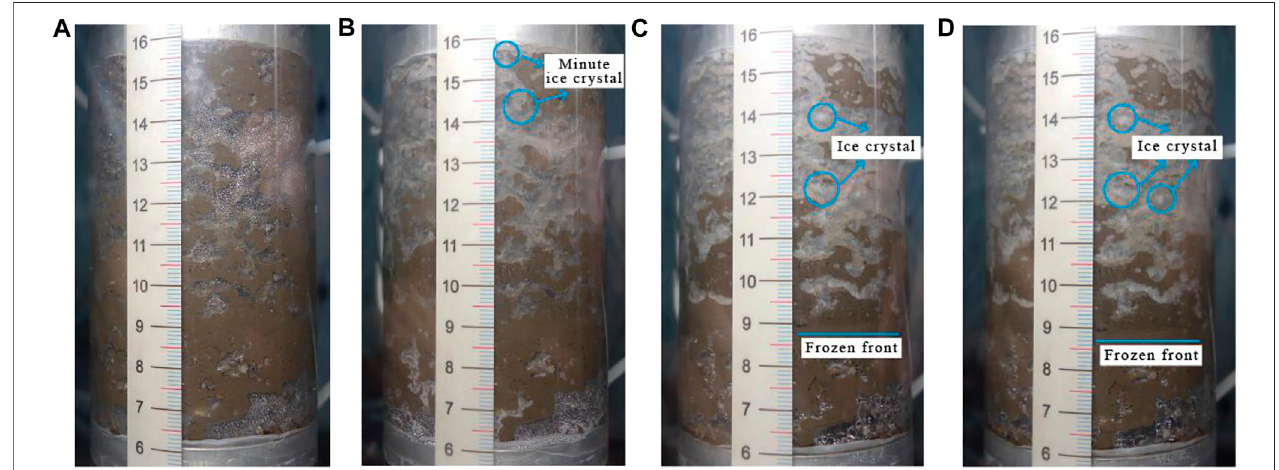
FIGURE 10 | States of CGS sample at (A) 0 h; (B) 10 h; (C) 96 h; and (D) 144